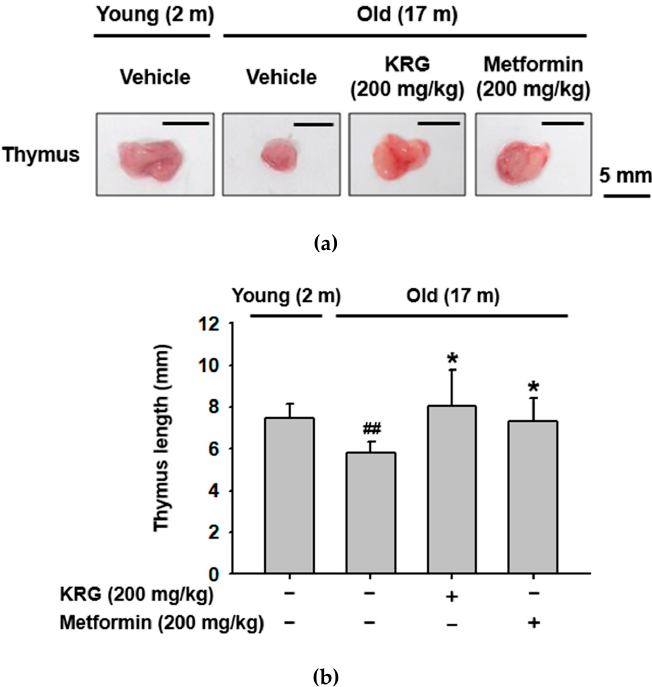
Figure 1. Korean red ginseng (KRG) inhibited aging-related thymic involution. ( a ) Thymi were excised from young (2 months old) and old (17 months old) mice orally dosed with KRG (200 mg / kg) or metformin (200 mg / kg) and photographed. ( b ) Thymic size (length) of the mice (n = 6) was measured and plotted. Scale bar = 5 mm. ## p < 0.01 compared to vehicle-administered control young mice, and * p < 0.05 compared to vehicle-administered control old